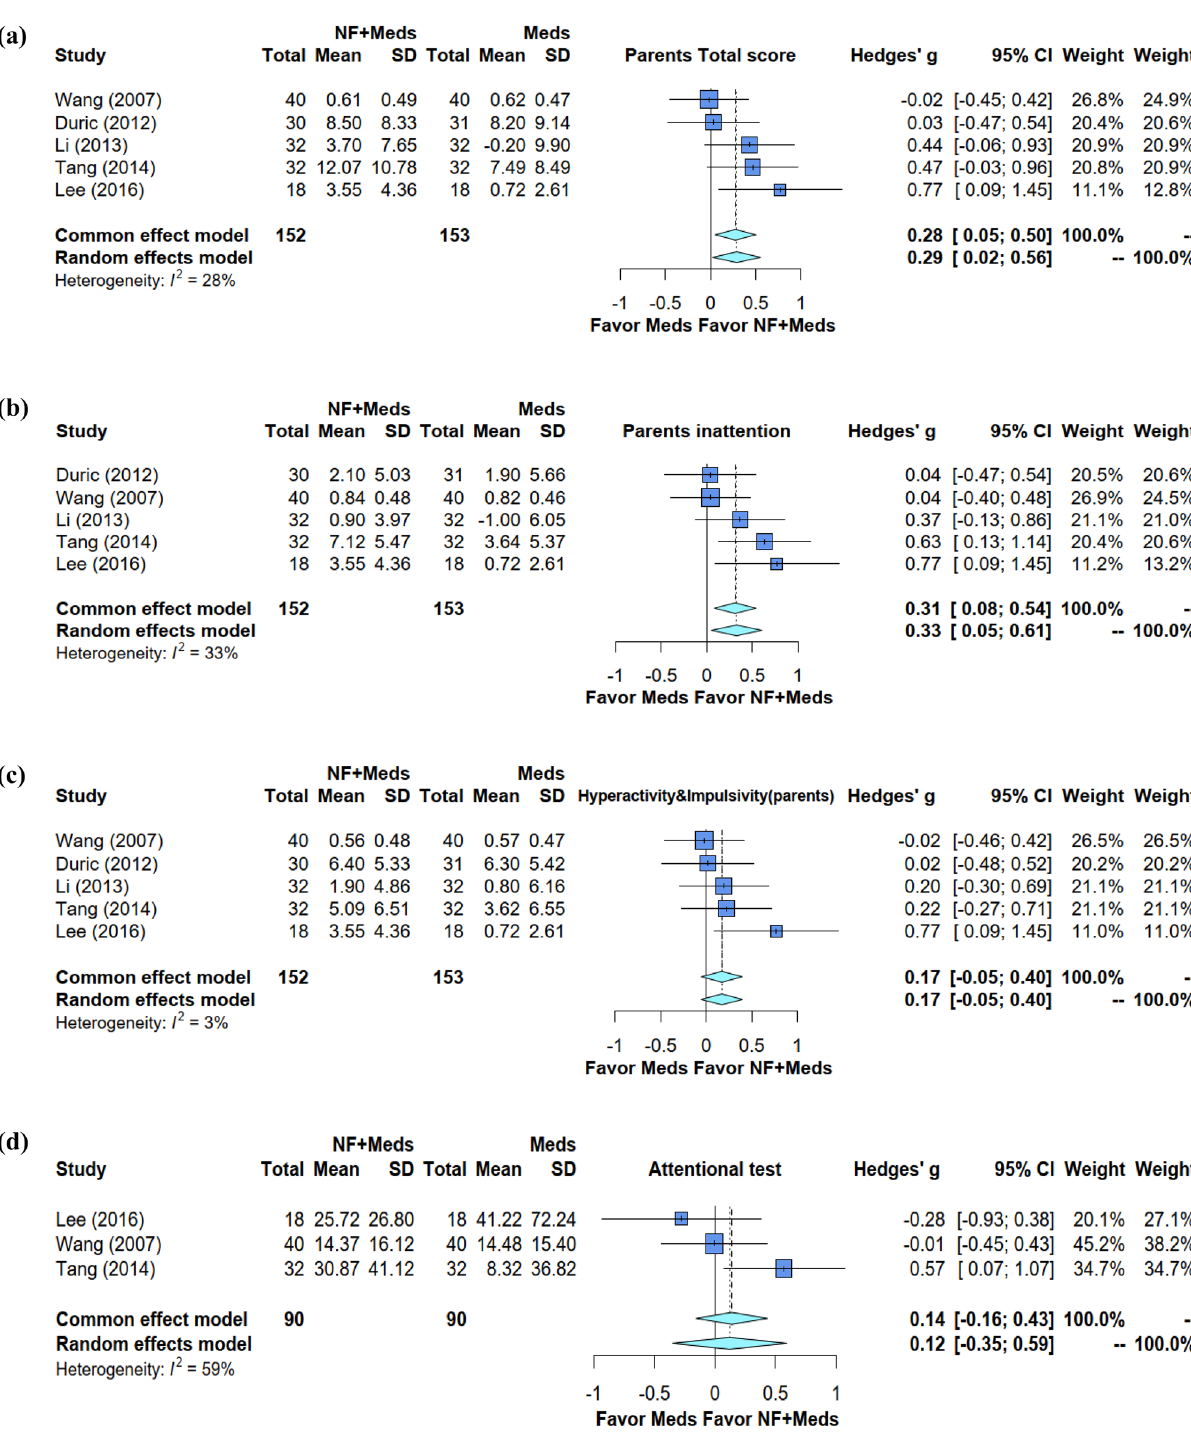
Figure 3. Forest plot of effect sizes for comparing the difference between combined treatment (EEG-NF + medications) and medication alone groups ( a ) in the improvement of global symptoms ( b ) inattention, ( c ) hyperactivity/impulsivity, and ( d ) attentional